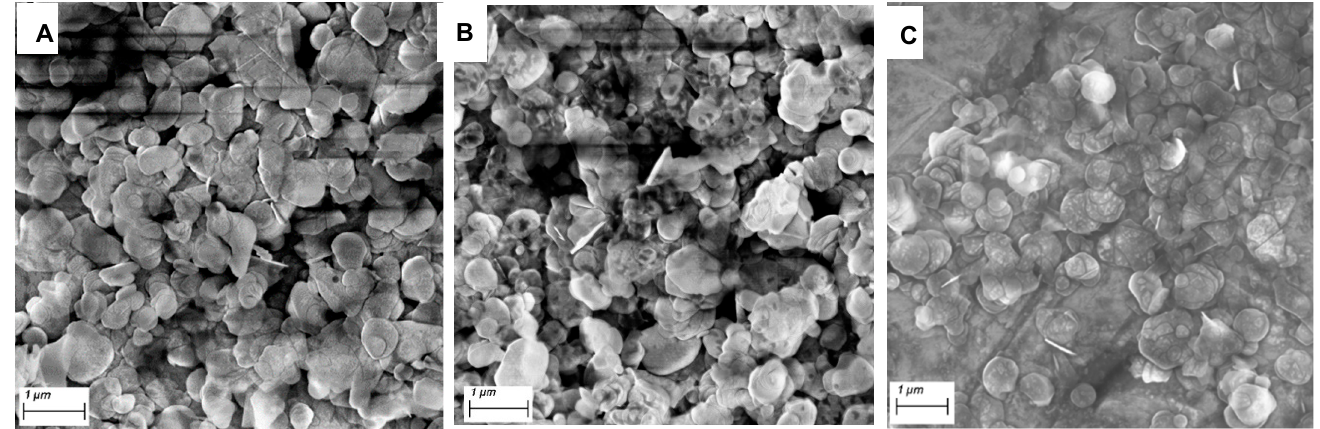
Figure 2. SEM images of exfoliated BN in ( A ) NMP, ( B ) IPA and ( C ) Millipore water where the nanosheets are present.